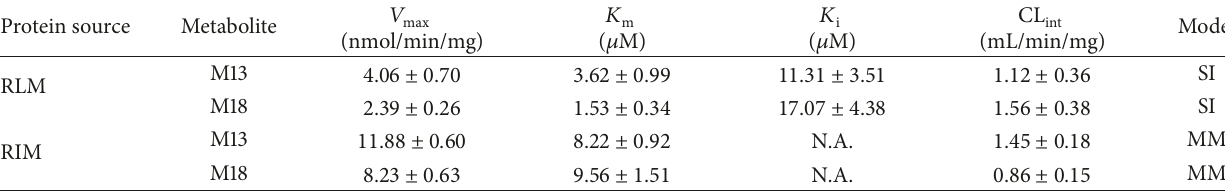
Table 3: Kinetic parameters of icaritin glucuronidation by RLM and RIM (mean ± SD). Protein source